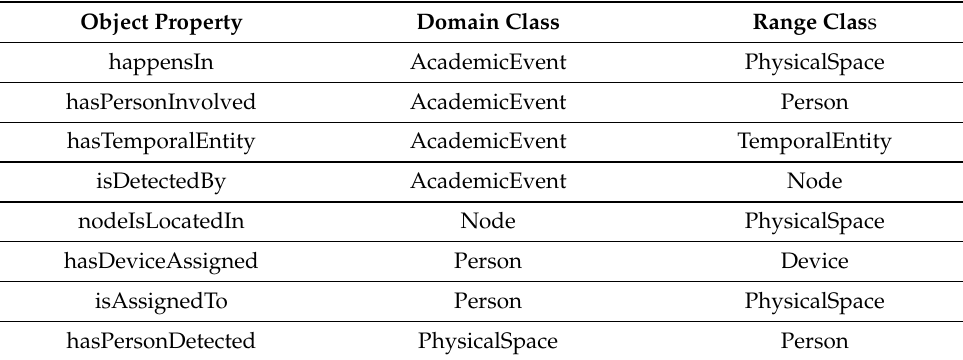
Table 3. Object properties between context